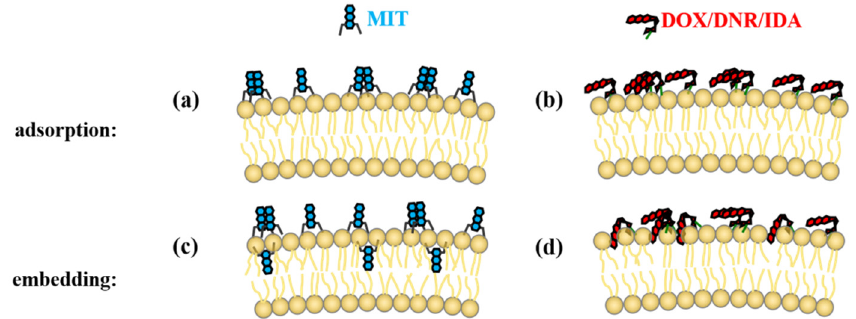
Figure 10. Time-dependent SHG field ( a ) and TPF intensity ( b ) curves obtained after the mixing of MIT, DOX, IDA, and DNR solutions with the DOPG vesicle solutions as shown in Figures 4, 5, and 9. The solid lines in frame ( a ) were from exponential (for MIT) or bi-exponential (for DOX, DNR and IDA) fittings. Some curves were shifted in the x direction to make the plot clear. Frame a is reproduced with permission [58]. Copyright 2020 Elsevier.